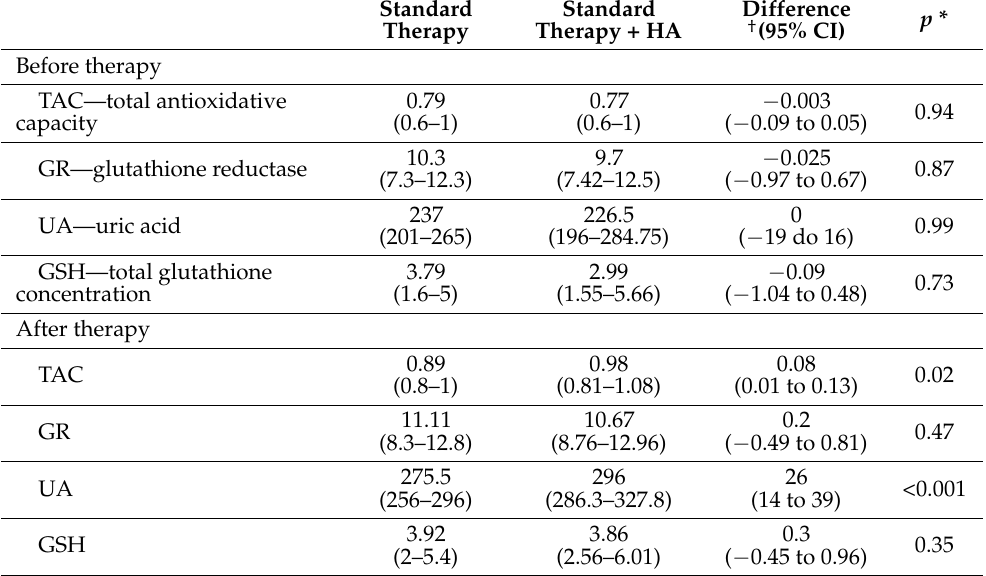
Table 1. Values before and after therapy for both